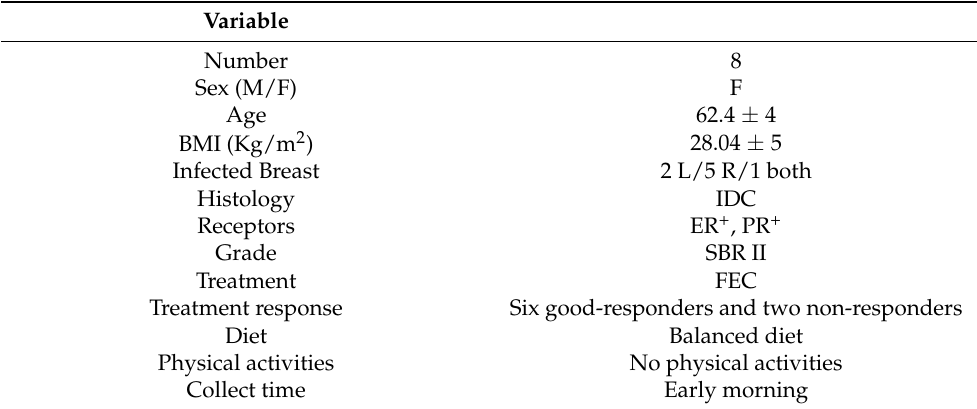
2 L: Left breast infected for two patients; 5 R: Right breast infected for five patients; 1 both: one patient with two in- fected breasts; IDC: invasive ductal carcinoma; FEC: 5-fluorouracil-epiribucine-cyclophosphamide; ER + : estrogen receptor + ; PR+: progesterone receptor +